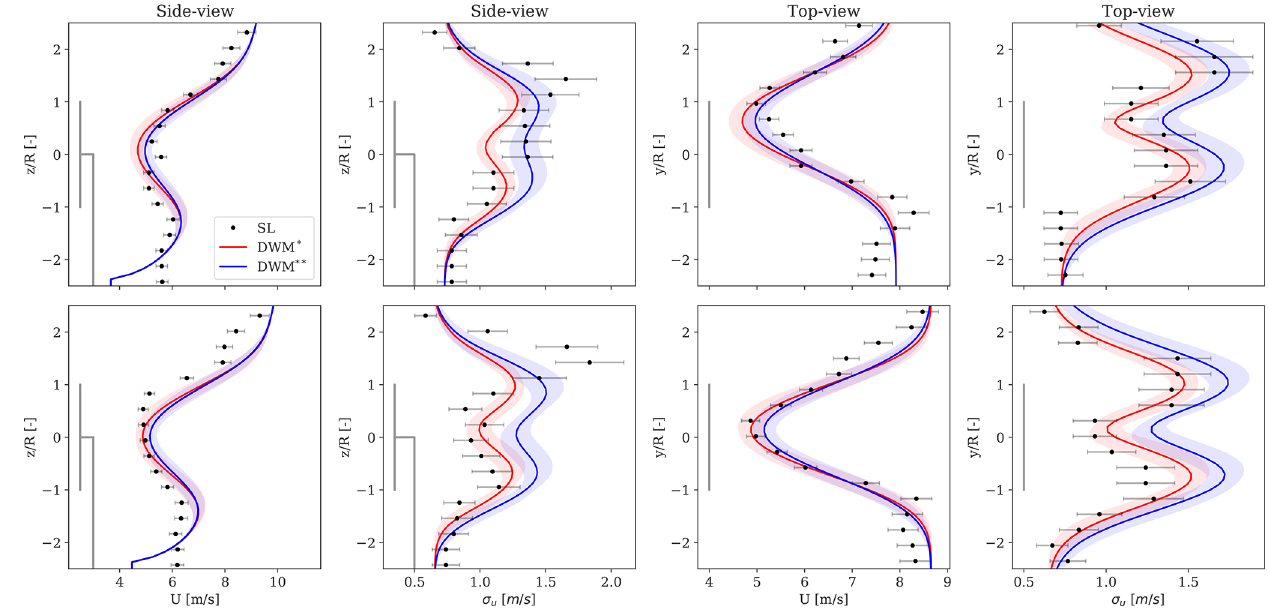
Figure 13. Comparisons between SpinnerLidar (SL)-measured and DWM-model-predicted spatial distribution of the mean and standard deviation velocity computed in the FFoR and obtained at 5 D in the wake region for two 10min periods. The predictive DWM model that incorporates the SpinnerLidar-tracked meandering time series is denoted by DWM ∗ (red line), and that based on the meandering model complemented by measured inflow turbulence fluctuations from the mast and yaw offsets is denoted by DWM ∗∗ (blue line). The solid lines represent the mean predictions, whereas the shaded areas indicate the 95% confidence intervals. The uncertainties in measurements are shown with error bars. The top view profiles are centred at hub height, whereas the side view profiles are centred along the vertical symmetry plane of the wake.